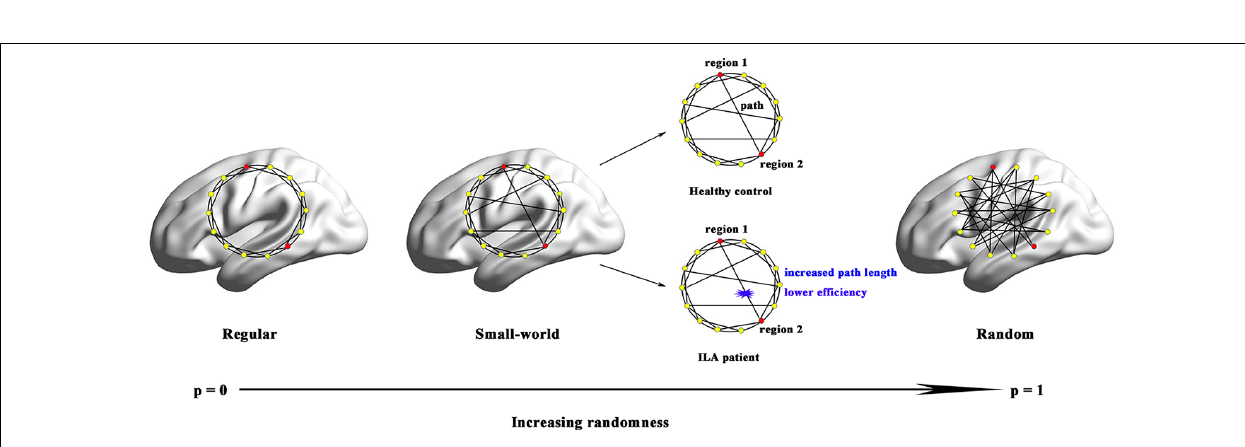
FIGURE 4 | Small-world models for ILA and healthy brain networks. Regular networks have a high local clustering C p (high local efficiency E loc ) and a long characteristic path length L p (low global efficiency E glob ). Random networks have a low C p (low E loc ) and a small L p (high E glob ). The C p and L p of small-world networks are located between those of regular and random networks. Although both ILA patients and healthy subjects exhibited small-world structure in their functional brain networks, the ILA patients were mainly associated with increased L p and lower E glob .